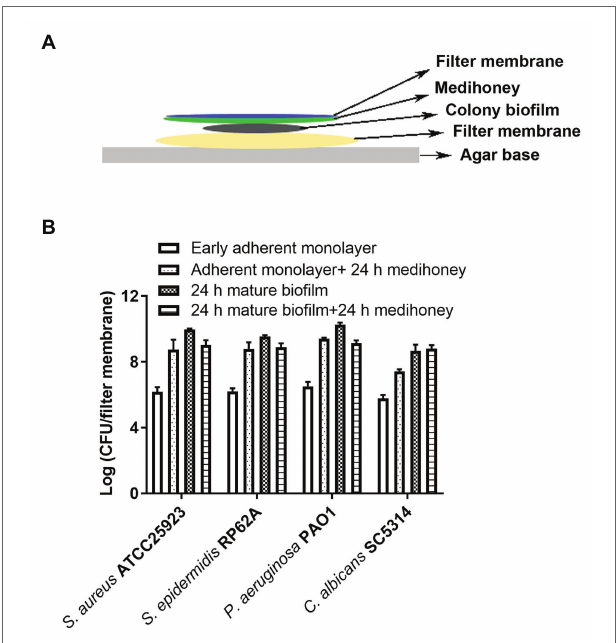
FIGURE 2 | Assessment of activities of MAWG against colony biofilms at different developmental stages. (A) Schematic description of the colony biofilm assay. (B) Antibiofilm activities of MAWG against early adherent monolayer and mature biofilms. MAWG was found unable to effectively kill adherent monolayers; adherent monolayers developed into mature biofilms [2–5 log (CFU/cm 2 )] after overnight treatment. Only ~1 log reduction in